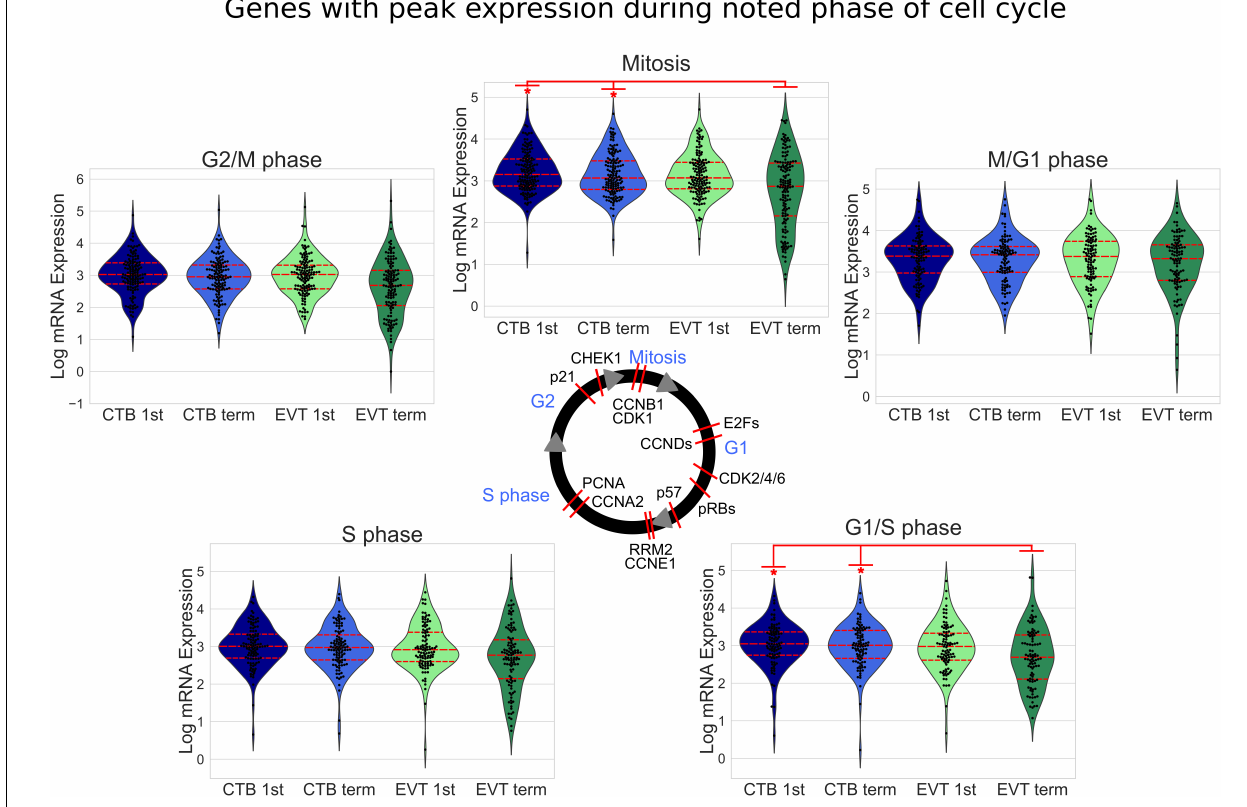
FIGURE 5 | Cell cycle-related gene expression in first trimester and term CTB and EVT. Expression of known cell cycle phase-related genes (Macosko et al., 2015) is shown. The median value of each gene in each group was used to create swarm/violin plots. Inner red dotted lines in swarm/violin plots represent the quartiles of the distribution ( p -value: * < 0.05 by t -test). Red lines on cell cycle figure represent location during cell cycle with reported peak expression of the labeled gene (protein names have been used in certain cases to represent multiple genes or because they are more commonly